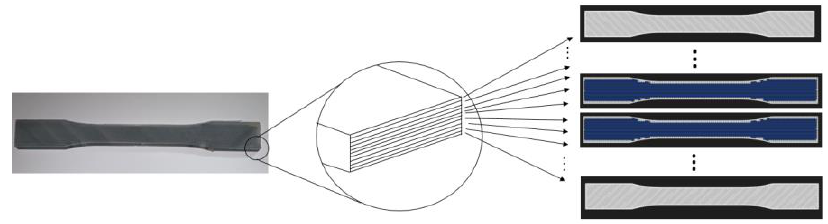
Figure 5. Schematic representation of layers in a CFRAM tensile